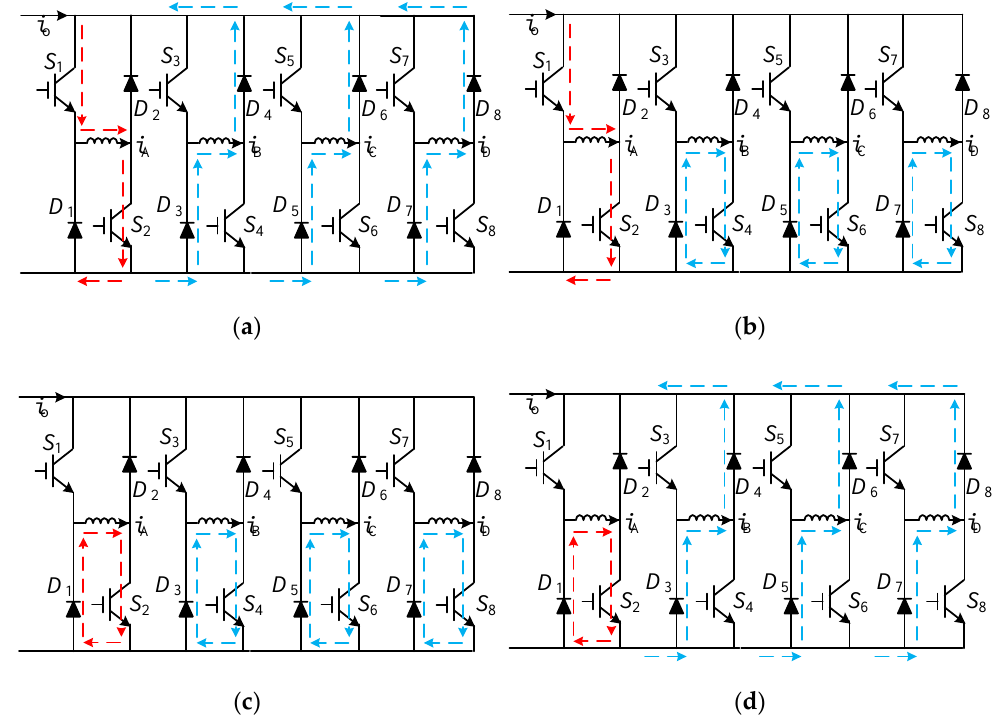
Figure 10. Four cases of speed regulating system: ( a ) case 1, ( b ) case 2, ( c ) case 3, and ( d ) case